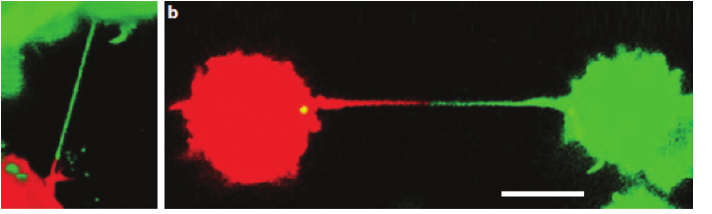
Figure 4 HIV bacteria transforms between two cells through a membrane nanotube (cited from